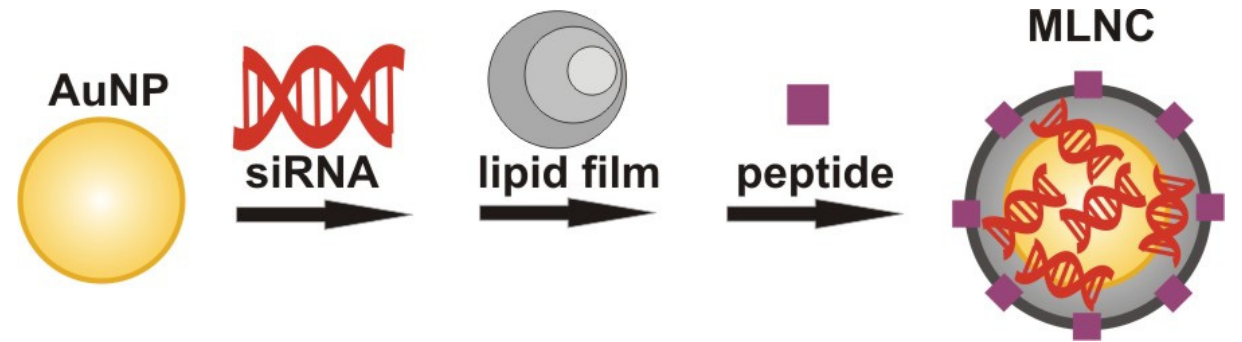
Figure 1. The fabrication and structure of the desired MLNC.